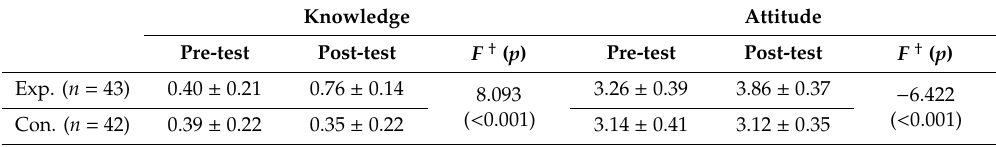
Table 4. Group di ff erences in knowledge and attitude regarding